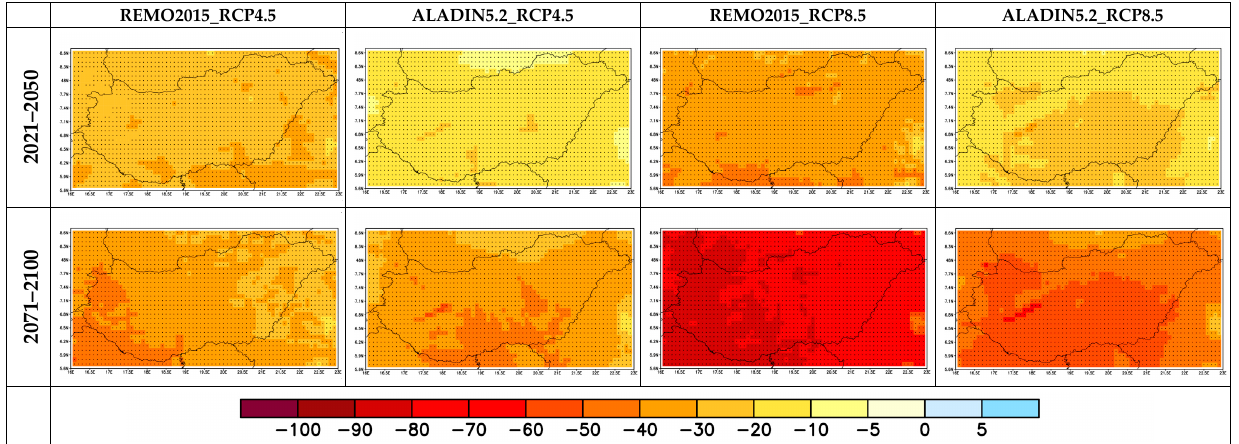
Figure 16. Relative change in the annual number of frost days (days) in Hungary for 2021–2050 and 2071–2100 based on the ALADIN5.2 and REMO2015 simulations. Reference period: 1971–2000.